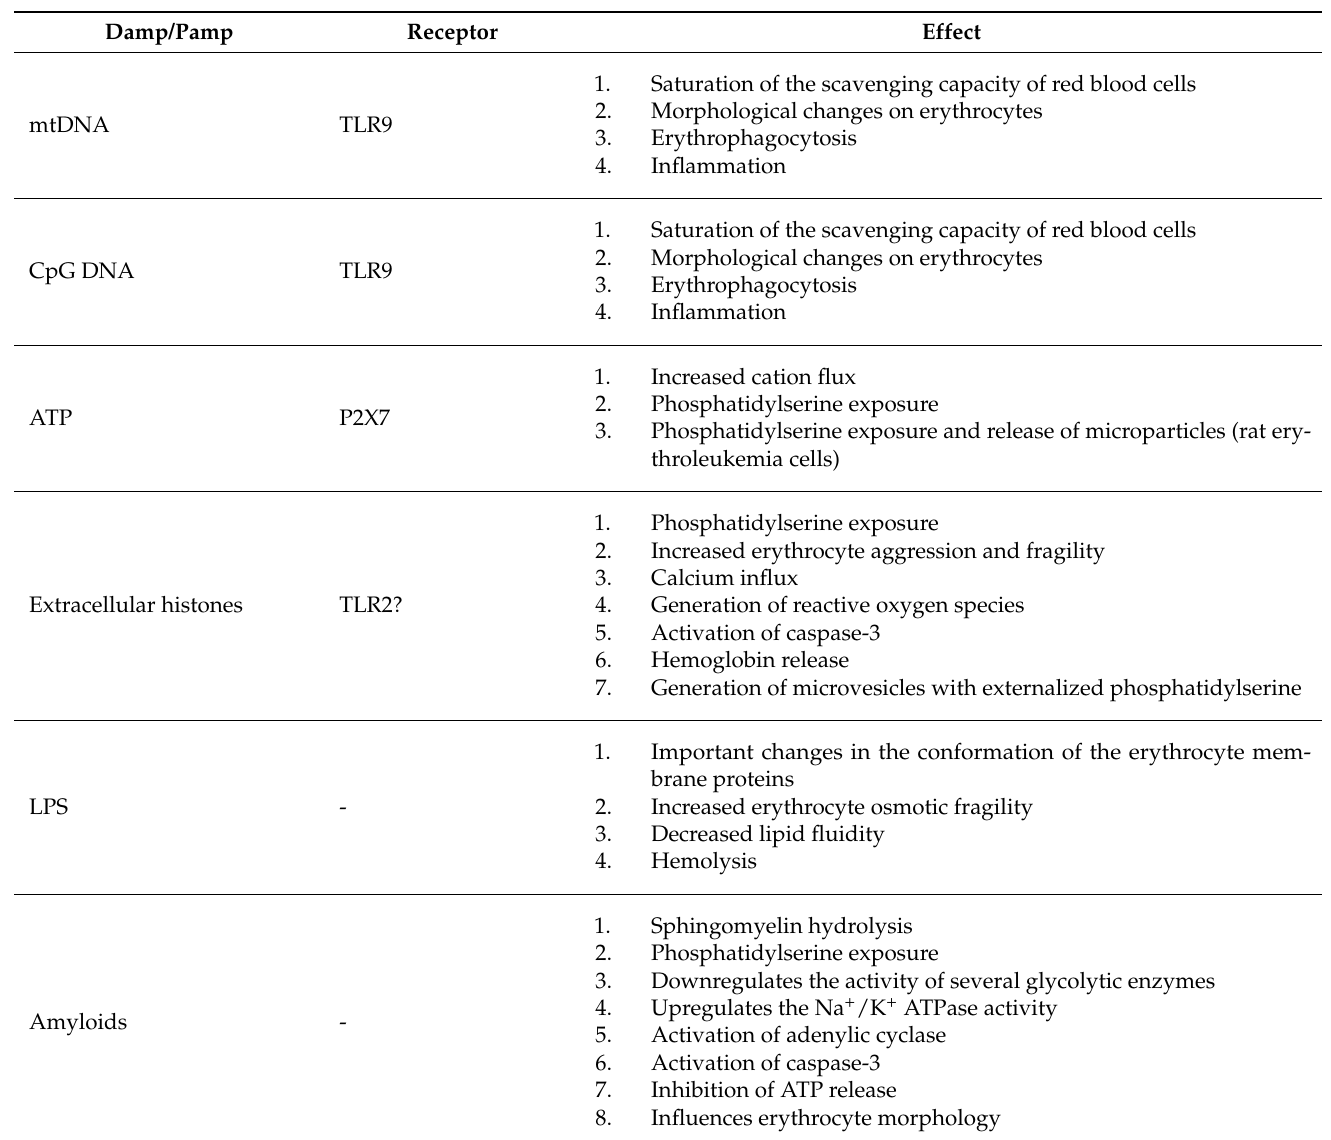
Table 1. Summary of the mechanisms underlying the response of red blood cells to pathogen- and damage-associated molecular